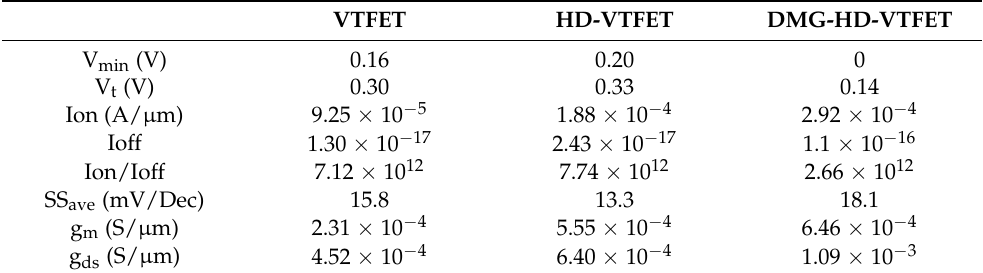
Table 2. DC characteristics comparison table of VTFET, HD-VTFET, and DMG-HD-VTFET at